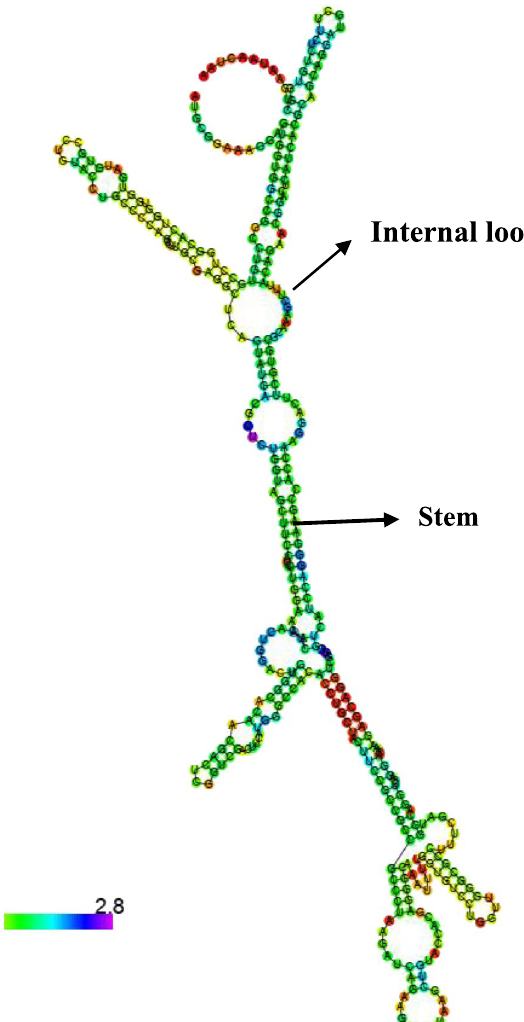
Fig. 6 mRNA structure of Pp- ALF showing stem-loop structure. The mRNA structure is colored by base pairing probabilities. A high base-pairing probability is indicated by the red color and a low base-pair probability is indicated by the blue